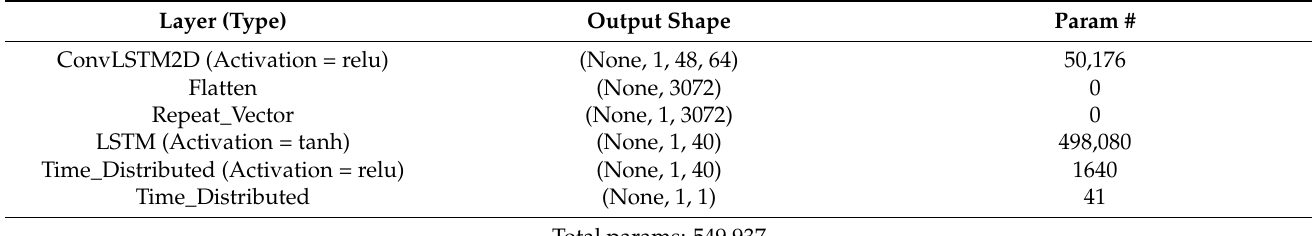
Table 8. CNN-LSTM